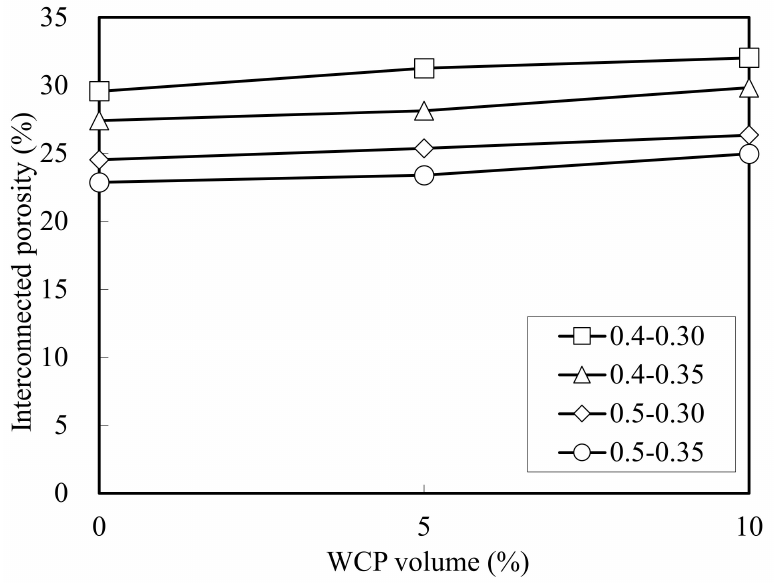
Figure 9. Variation in interconnected